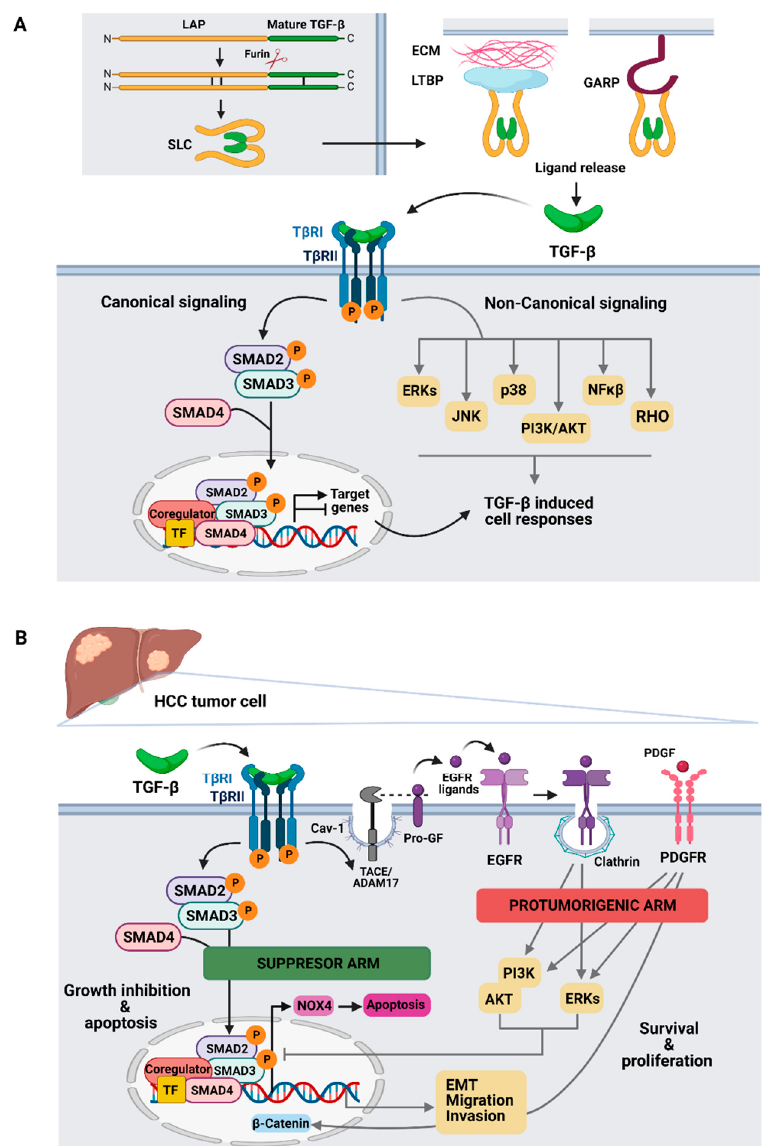
Figure 1. TGF- β -mediated signaling in liver cells. ( A ) Canonical (SMAD-dependent) and non-canonical (non-SMAD) signaling pathways. ( B ) TGF- β dual role controlling tumor suppressor and protumorigenic responses in hepatocellular carcinoma. Cav-1: Caveolin, ECM: extracellular matrix, GF: Growth Factor, LTBP: latent TGF- β binding proteins, SLC small latent complex, LAP: Latency associated peptide. Figure was created with BioRender.com.